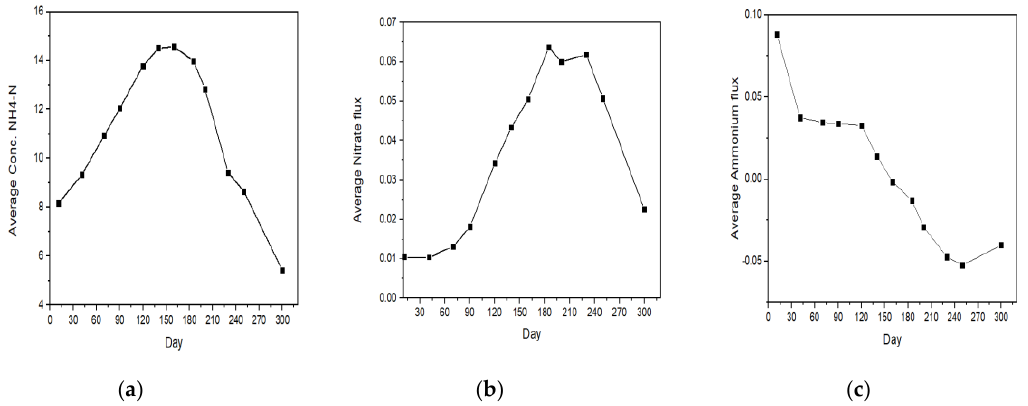
Figure 10. Seasonal variation of ( a ) average Conc NH 4 –N, ( b ) average nitrate (NO 3 ); and ( c ) average ammonium (NH 4 ) fluxes at Taihu, China.